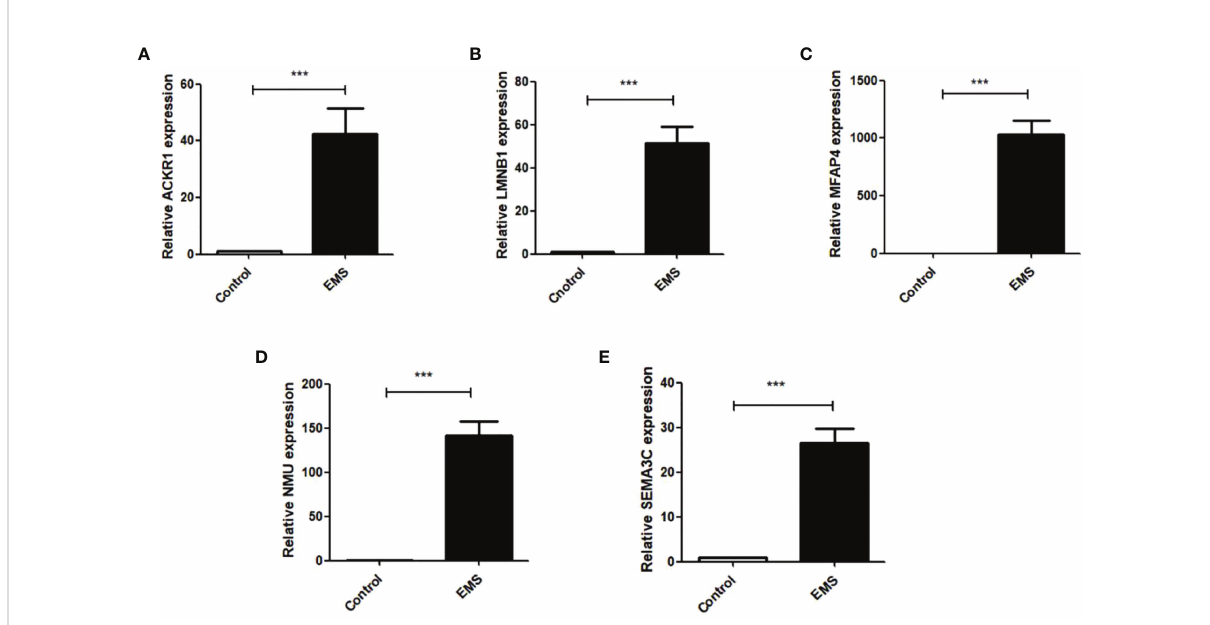
FIGURE 9 Q RT-PCR was used to detect the mRNA expressions of ACKR1, LMNB1, MFAP4, NMU and SEMA3C in normal female endometrial tissues and ectopic endometrial tissues of endometriosis patients. The results showed that: (A) the expression of ACKR1 was increased in the EMS group (*** P <0.001); (B) the expression of LMNB1 was signi fi cantly increased in the EMS group (*** P <0.001); (C) the expression of MFAP4 was increased in the EMS group (*** P <0.001); (D) the expression of NMU was signi fi cantly increased in the EMS group (*** P <0.001); (E) the mRNA expression of SEMA3C was signi fi cantly increased compared with the control group (*** P